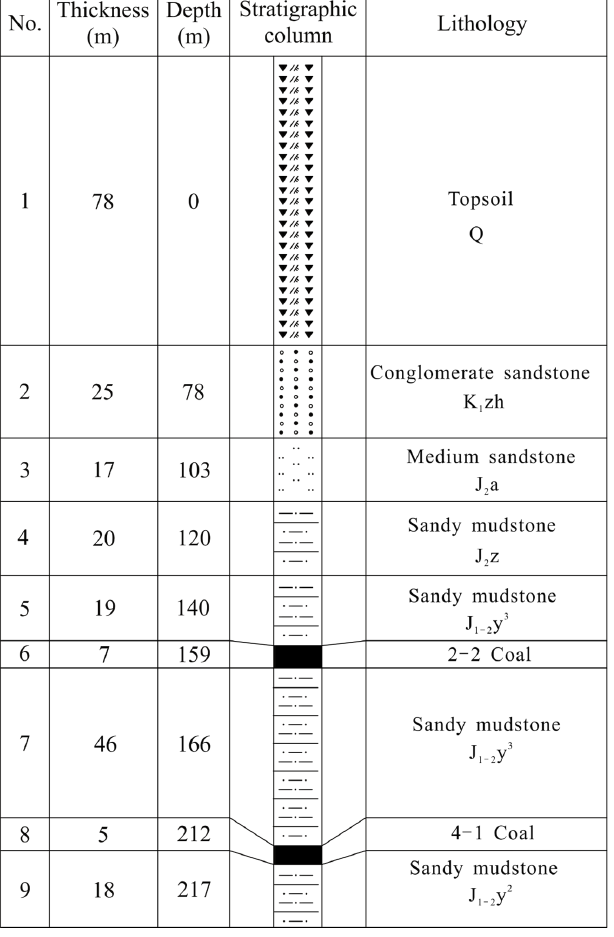
Figure 3. Stratigraphic section of Yangjiacun Coal Mine, according to the borehole data of GJ18 (as marked in Figure 4). The 2 ‐ 2 coal seam in Yangjiacun Coal Mine has 6 panels, which correspond with panels No.